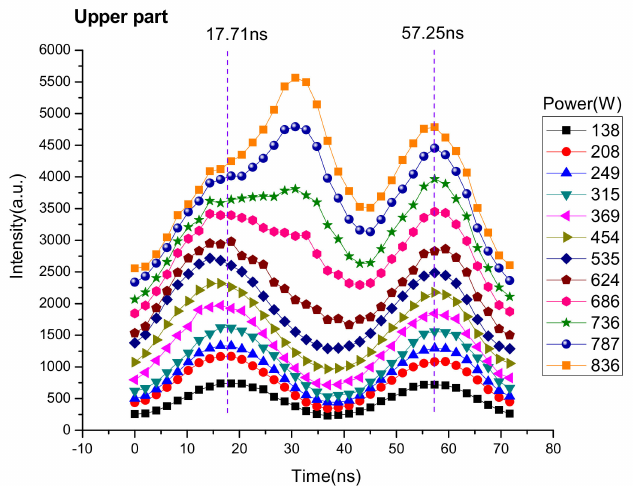
Figure 5. The curves of luminescence intensity on surface of the upper electrode in 4.4 mm argon DBD in one current cycle at different